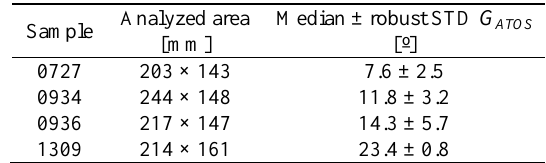
Table 2. The size of analysed area, and the median and robust STD of reference ATOS Grasselli parameters ( G ATOS ) calculated for 72 analysis directions